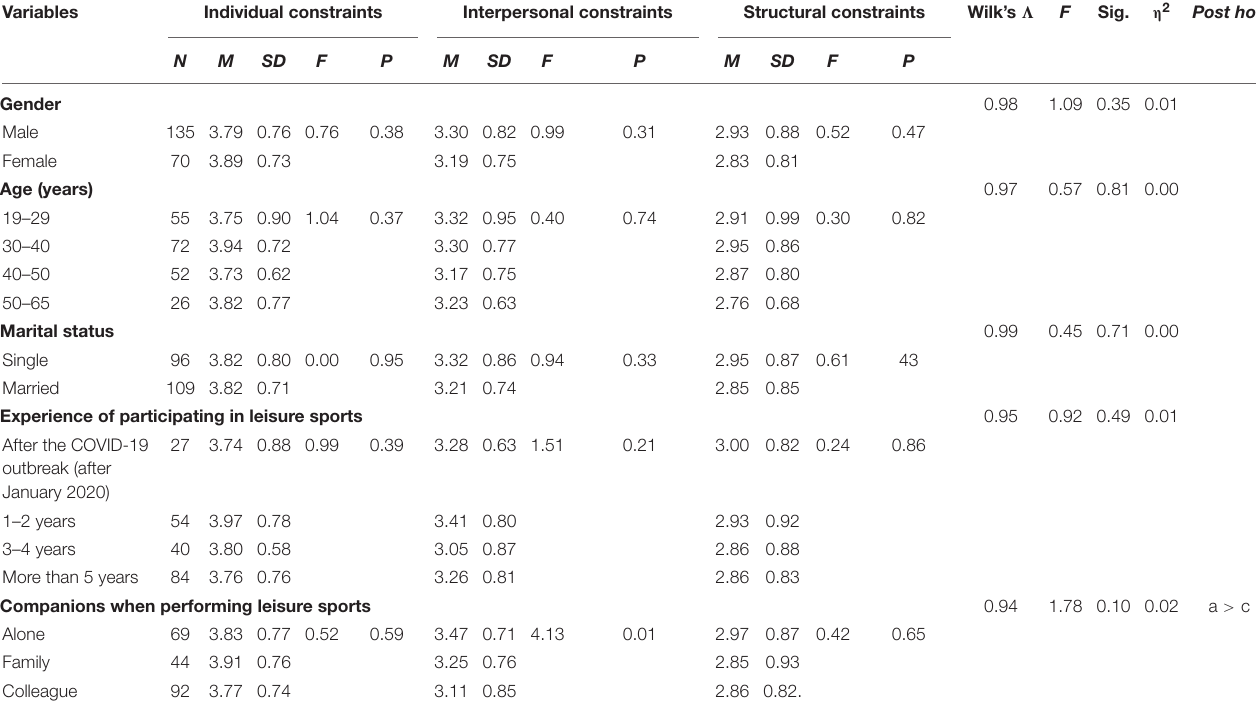
TABLE 4 | Differences in the leisure constraints of outdoor leisure sports participants in terms of demographic characteristics ( N =